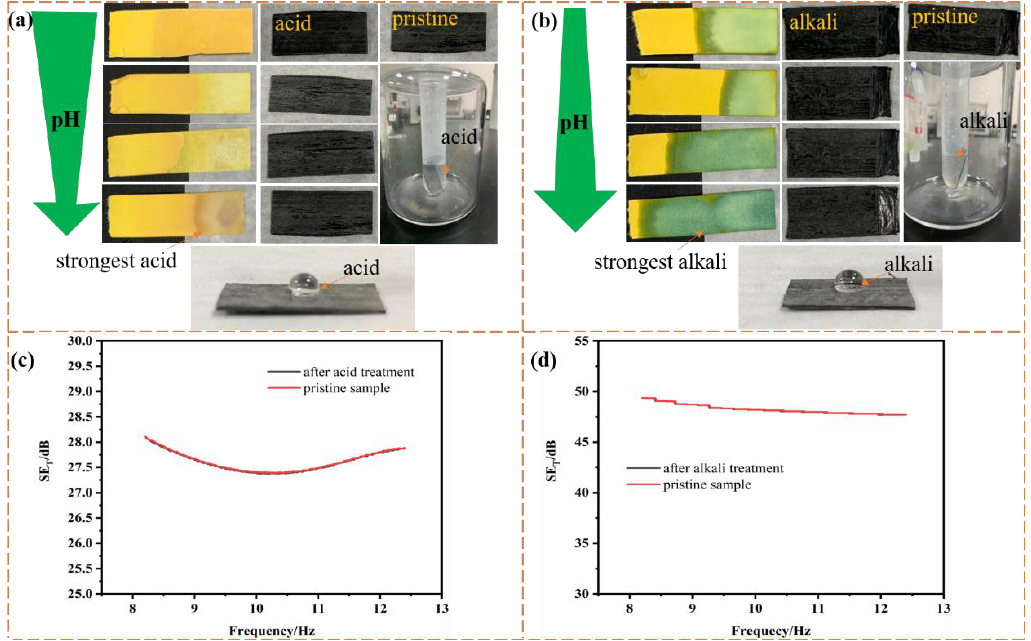
Figure 9. ( a , b ) Digital images and ( c , d ) electromagnetic shielding efficiency of samples 8, 14 before and after acid-alkali treatment.